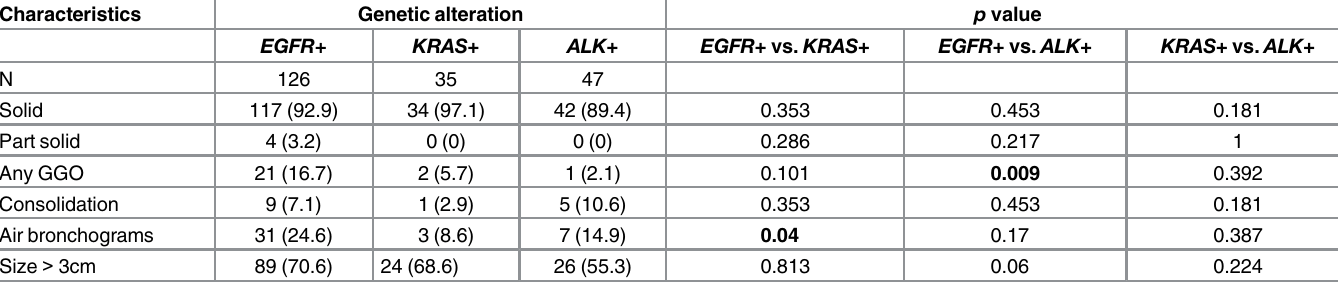
Table 2. Imaging characteristics of the main tumor in stage IIIB – IV patients with lung adenocarcinoma.